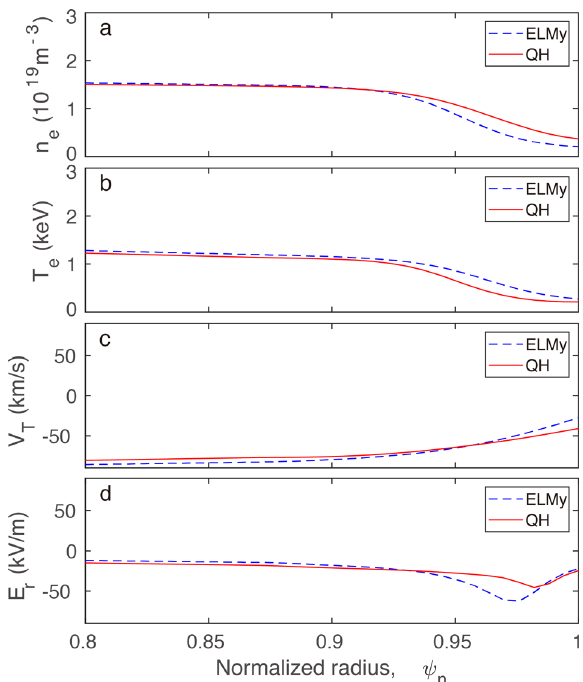
Fig. 2 Effects of the inner and outer gaps on the operational regimes of high-con fi nement mode. Transition from the high-con fi nement mode with edge-localized mode (ELMy H-mode) to quiescent-mode (QH-mode) was observed in a gap scan during discharge E042868 (solid red lines), while a gap- fi xed discharge (E042870 shown in blue dashed lines) exhibited a stationary high-con fi nement mode without edge-localized-mode. a GAPIN (de fi ned by the distance between the last closed fl ux surface and the wall at the inboard mid-plane), b GAPOUT (de fi ned by the distance between the last closed fl ux surface and the wall at the outboard mid-plane), ( c ), and ( d ) D α emission from the divertor, in which hatched area denotes the time at which the GAPOUT/GAPIN values for discharge E042868 almost matched those of discharge E042870.